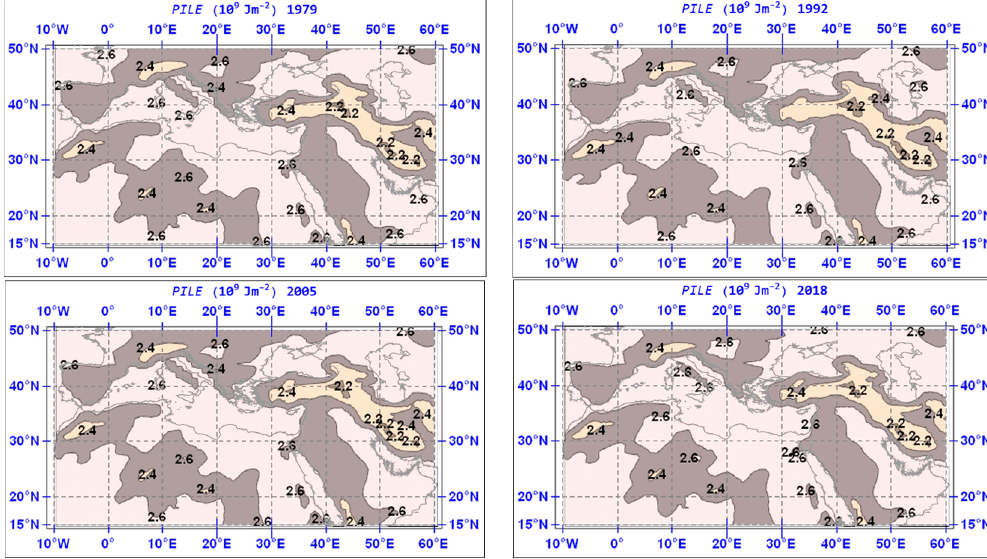
Figure 13. Same as Figure 4 but for PILE . Isopleths are drawn for every 0.2 × 10 9 Jm − 2 .